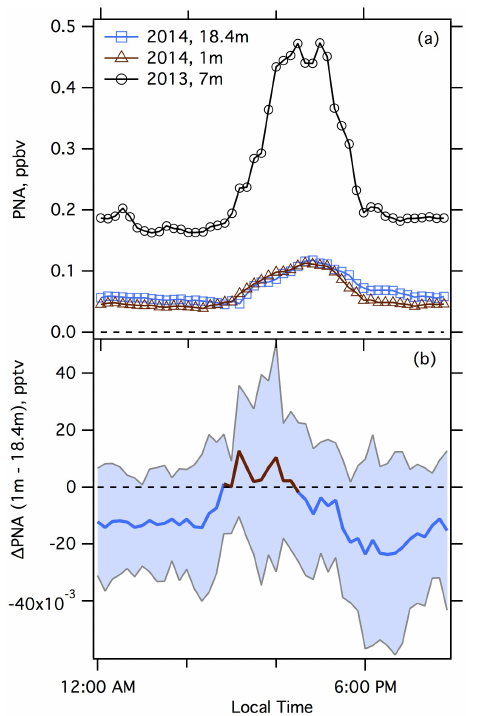
Figure 4. Diurnal profiles of PNA are shown in panel (a) for the full measurement period during the UBWOS 2013 and 2014 stud- ies, with the 2014 study separated based on the sampling height location. Panel (b) presents the difference in the 1 and 18.4m PNA measurements for duration of the 2014 study, where a positive value (brown) indicates larger concentrations at the ground and a negative value (blue) suggests a relative PNA depletion in the 1m measure- ments. The shaded region represents 1 standard deviation on the hourly average for the entire measurement period.